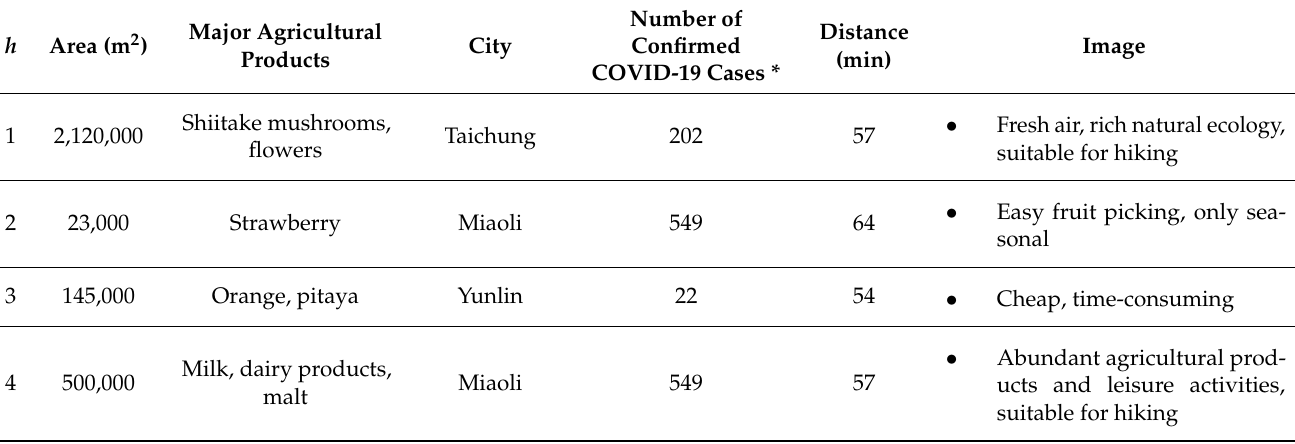
Table 2. Leisure agricultural park details.